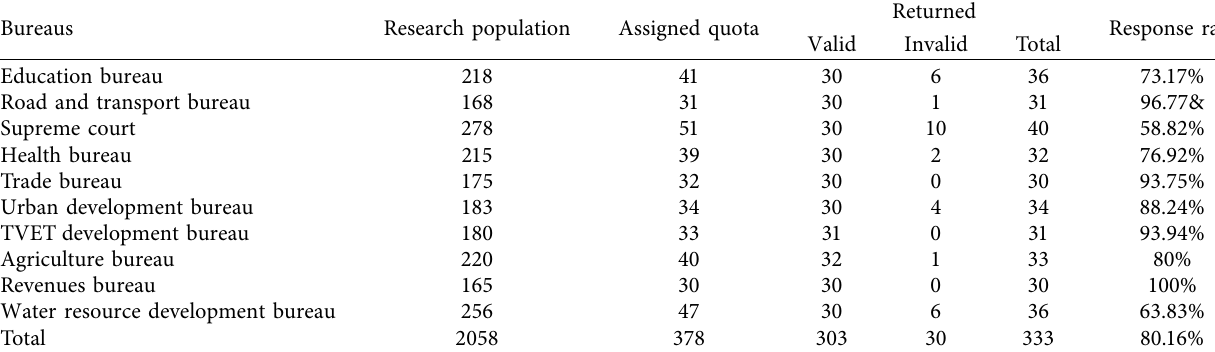
Table 1: Population, sample cluster sample size, and response